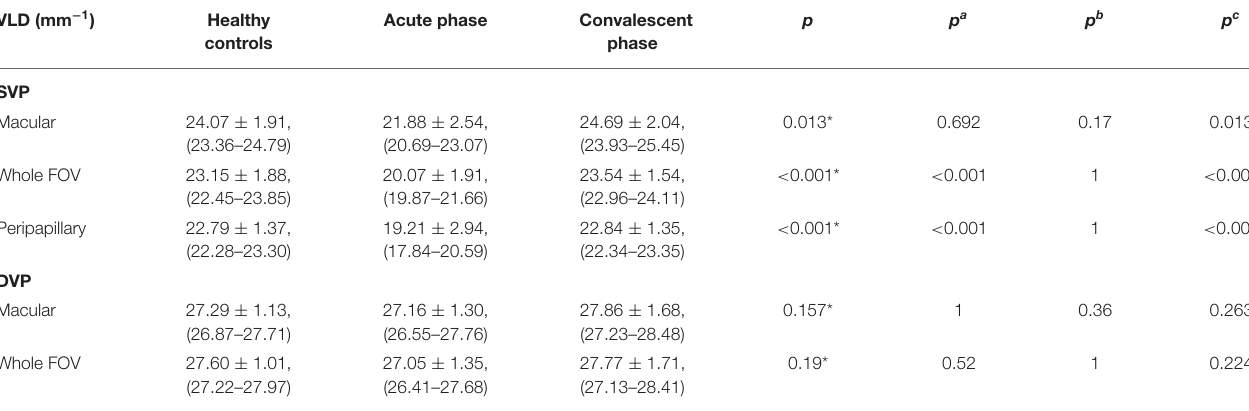
TABLE 3 | The vascular length density (VLD) measurements in different slabs and regions.